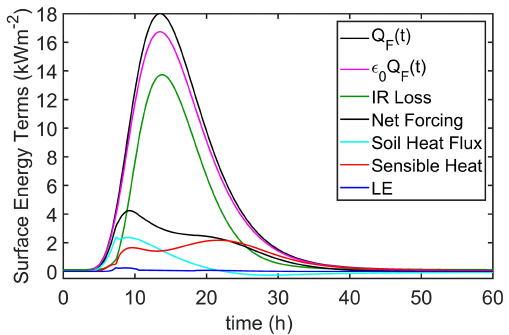
Figure 5. Soil surface energy balance components for the 26 April 2004 MEF burn resulting from the full surface energy bal- ance model (Eq. 16). The parameters for the forcing function, Q F (t) or Eq. (15), are Q in = 120Wm − 2 , Q Fmax =18kWm − 2 , t m = 13 . 5h and t d = 35h. The net forcing is defined as the difference − between the radiative terms, i.e., (cid:15) 0 (θ 0 )Q F (t) − (cid:15) 0 (θ 0 )σ [ T 4 K 0 ] , which, from Eq. (16), is equal to the sum of the three (cid:15) a (ρ va )T 4 Ka E 0 + G 0 . Figure 6 nonradiative terms, i.e., ρ a c pa C H [ T 0 − T a ]+ L ∗ v0 is an magnified version of the net forcing and these three energy components.